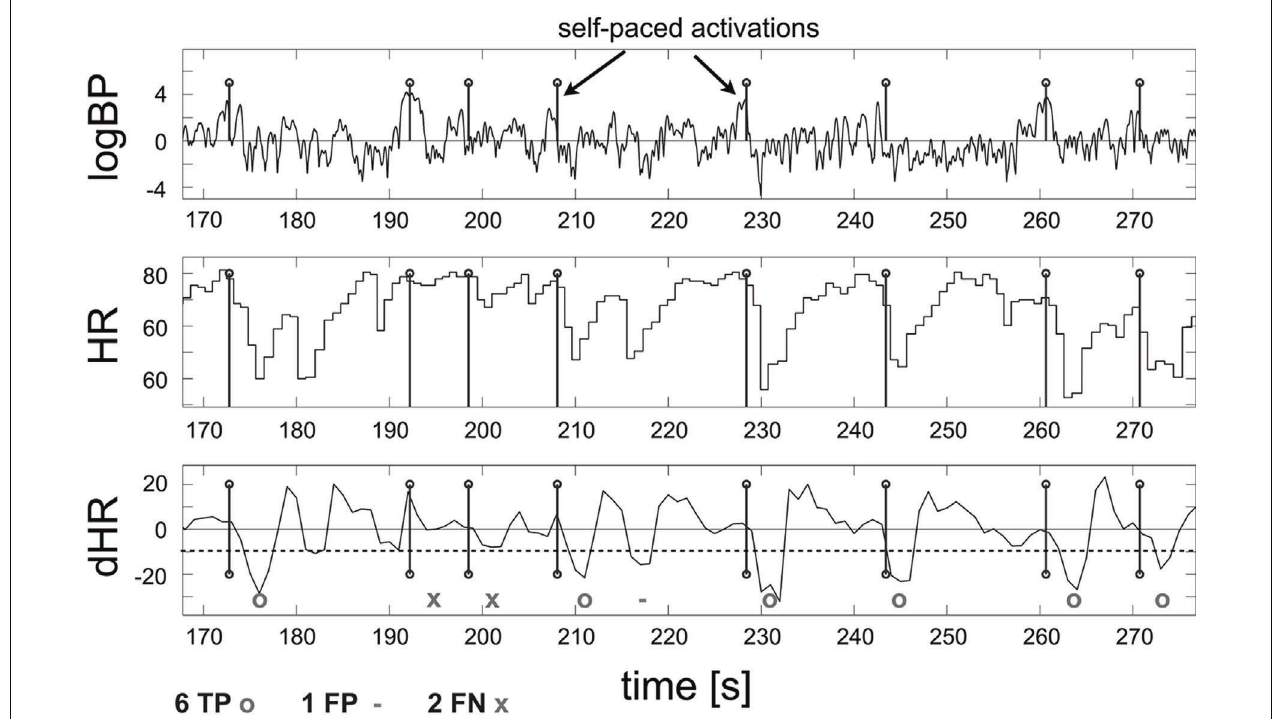
FIGURE 6 | Beta power and HR changes during self-paced motor imagery. This Figure shows logarithmic beta power with online detected output signals (vertical lines) during mental practice in virtual environment (for details see